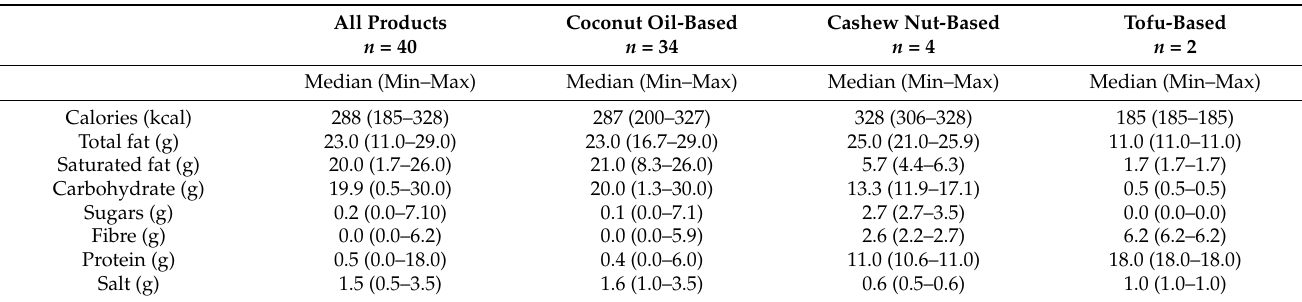
Table 1. Median (minimum-maximum) values of calories and nutritional content in plant-based cheese alternatives per 100 g, by ingredients’ composition.